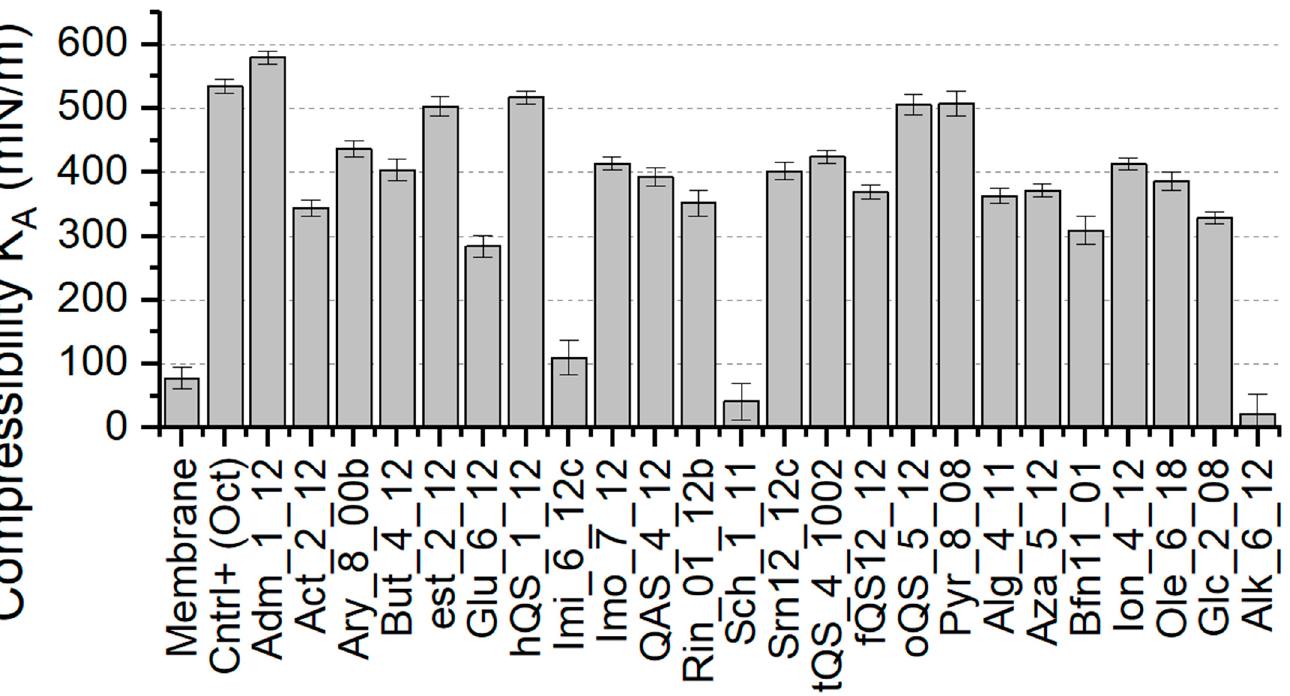
Figure 3. Determined values of compressibility (K A ) for membrane system with incorporated Gemini molecules.